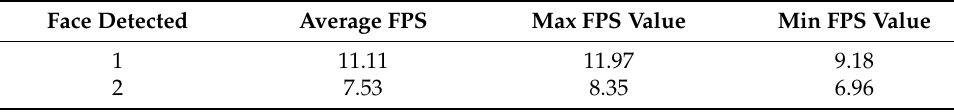
Table 16. System performance in ROS with max_num_faces: